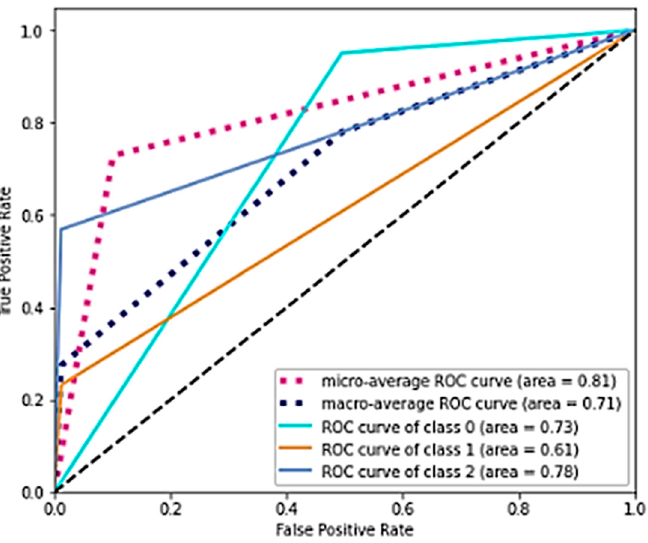
Figure 6. ROC curves. The discontinuous black line represents the "no benefit" line, i.e., a causal classifier with area = 0.5.